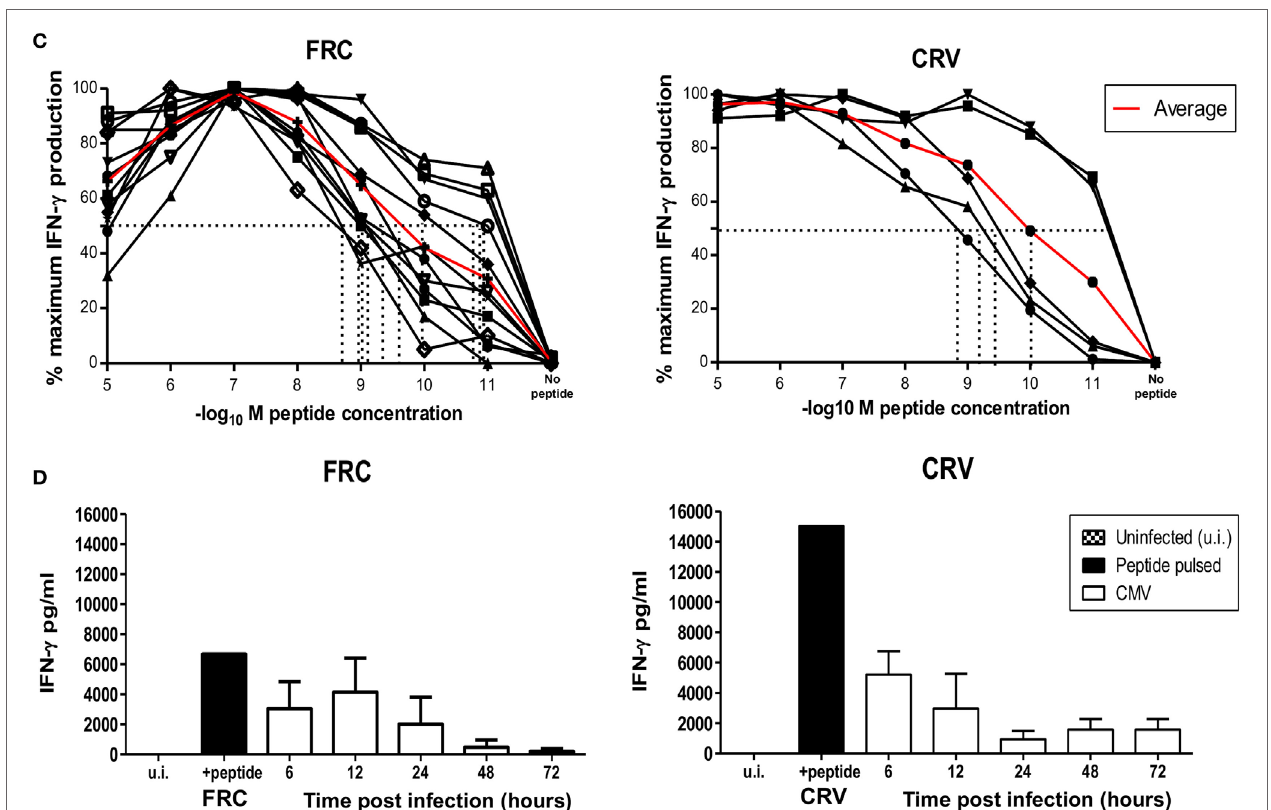
FigUre 6 | HLA-Cw*0702-restricted CD8 + T-cells have high avidity and recognize cells in the immediate-early time point of viral infection. (a) TNF- α production by PBMCs in response to HLA-Cw*0702-restricted peptide gradient. 50,000 PBMCs were incubated with peptide concentration of 50 pg (10 − 11 ) to 50 µg (10 − 5 ) in the presence of brefeldin A followed by intracellular cytokine staining for TNF- α . The EC 50 was defined as the peptide concentration that induced the 50% maximal TNF- α production by HLA-Cw*0702-restricted CD8 + T-cells as a percentage of the total CD8 + T-cell population. Percentages represent the percentage of the total CD8 + T-cell pool responding to that concentration of HLA-Cw*0702-restricted peptide. The two highest (50 and 5 µg) and two lowest (500 and 50 pg) peptide concentrations are shown as representative examples. (b) Functional avidity of HLA-Cw*0702-restricted cytomegalovirus (CMV)-specific PBMC. 50,000 PBMCs from three young (32, 46, and 56 years) and three elderly donors (83, 91, and 91 years) were incubated with peptide concentrations of 50 pg (10 − 11 ) to 50 µg (10 − 5 ), and the EC 50 was defined as in panel (a) . This was determined within GraphPad Prism 6 by applying a sigmoidal dose response curve. Percentages represent the percentage of the total CD8 + T-cell pool responding to that concentration of HLA-Cw*0702 peptide. Younger donors ( < 70 years) are represented by dashed lines, and older donors ( > 70 years) represented by solid black lines. Lines represent the average percentage of PBMCs responding to that peptide gradient (FRC—left graph and CRV—right graph) within n = 3 donors per age group. (c) Functional avidity of HLA-Cw*0702-restricted CMV-specific CD8 + T-cell clones. CD8 + T-cell clones were isolated by limiting dilution analysis from HLA-Cw*0702 + CMV-seropositive donors. 1,000 CD8 + T-cell clones were cocultured for 16 h with 5 × 10 4 peptide-pulsed LCL loaded with a peptide concentration gradient of 50 pg (10 − 11 ) to 50 µg (10 − 5 ). CD8 + T-cell activation was analyzed by IFN- γ ELISA. n = 12 clones for FRC and n = 5 for CRV. The EC 50 was determined as in panel (b) . The red line represents the average EC 50 avidity of the CD8 + T-cell clones. (D) Time course of recognition of HLA-Cw*0702-restricted CMV peptides during viral infection. The presentation of HLA-Cw*0702-restricted peptides during CMV infection was determined by recognition by virus-specific T-cell clones following infection of MRC5 fibroblasts ( HLA-A2 + HLA-Cw*0702 + ) in vitro . 10,000 CD8 + T-cells were cocultured with the infected fibroblasts, and IFN- γ ELISA was used to measure peptide recognition at the indicated time points. Left graph = FRC-specific T-cell clones and right graph = CRV-specific T-cell clones. n = 3–6 per time point and n = 3 clones tested per specificity. ui, uninfected cells; peptide, target cells pulsed with cognate peptide. Target cells were infected with AD169 virus at an MOI of 5. The peptide-pulsed control bar represents the average of all experiment